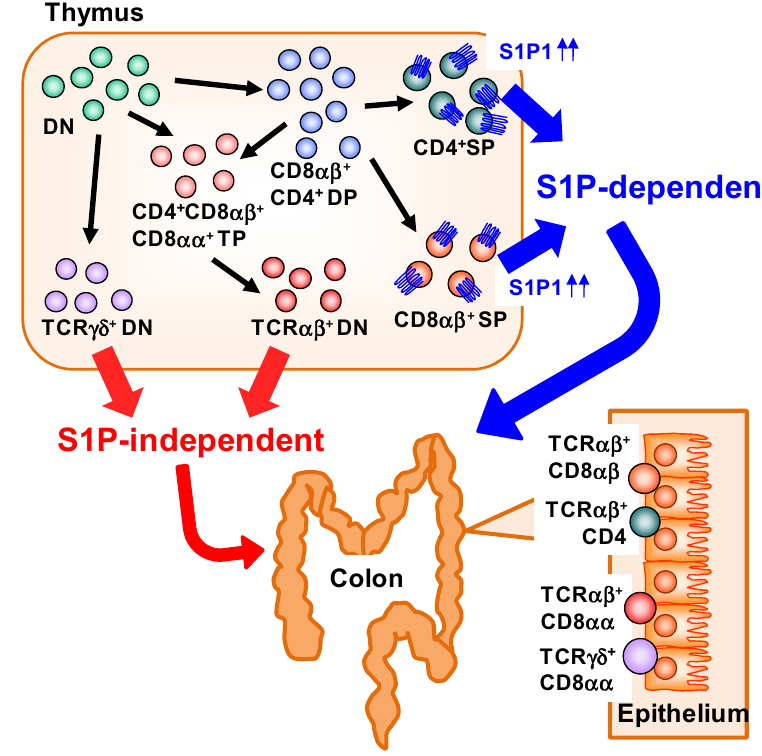
Figure 3. Distinct dependency on S1P in T-cell trafficking into the colonic epithelium. In the thymus, CD4 − CD8 − double-negative (DN) thymocytes differentiate into CD4 + CD8 + double-positive (DP) thymocytes and then into single-positive (SP) thymocytes expressing either CD4 or CD8 and αβ TCR. These SP thymocytes express high levels of S1P1 and migrate out from the thymus and into the colon in an S1P-dependent manner. DN